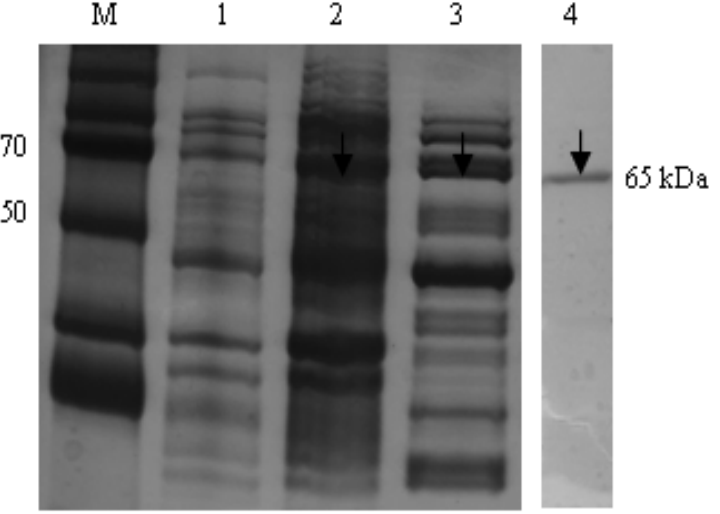
Figure 3. Purification of HCV NS5B viral protein. It represents the SDS-PAGE 10% gel showing NS5B protein with his-tag. M, protein marker; lane 1, before induction lysate; lane 2, total lysate; lane 3, soluble lysate; lane 4, his-tag form of purified HCV